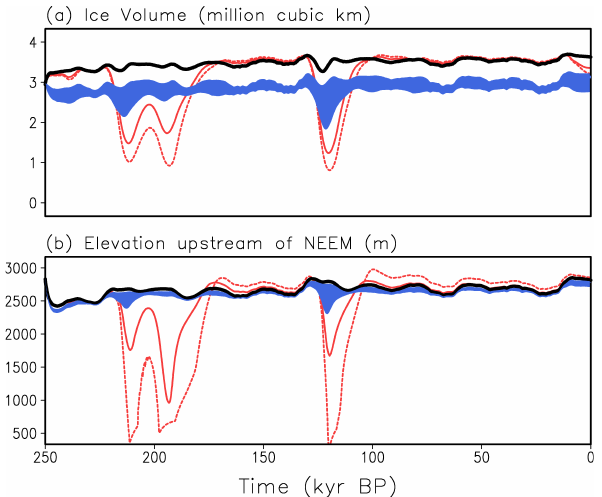
Figure 8. Time series of the simulated Greenland ice sheet evolu- tion during the last two glacial cycles. Blue shading represents the range of valid model versions including our discharge parameteri- zation. Black and red lines show simulations without the discharge parameterization ( c d = 0). Solid black lines indicate the central run of a set of optimized simulations by Robinson et al. (2011). The red lines are from simulations found via shape-only tuning of the melt parameter (see main text for explanation). In particular, a simula- tion with c m =− 42Wm − 2 , found by minimizing err( H ) (solid red line) and, alternatively, with c m =− 40Wm − 2 , determined by min- imizing err( V ) (dashed red line). (a) Ice volume of the Greenland ice sheet. (b) Surface elevation at the NEEMup location.